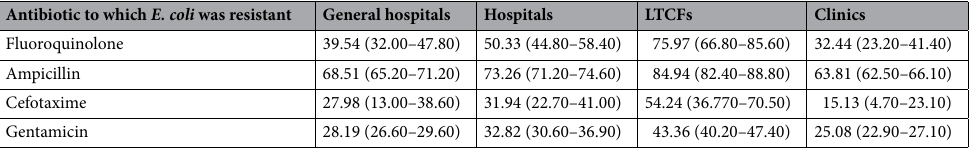
Table 2. Antibiotic resistance rate of Escherichia coli in South Korea between 2007 and 2018. Each value in the cell indicates the mean antimicrobial resistance rate and the range (min–max). LTCFs long-term care facilities.